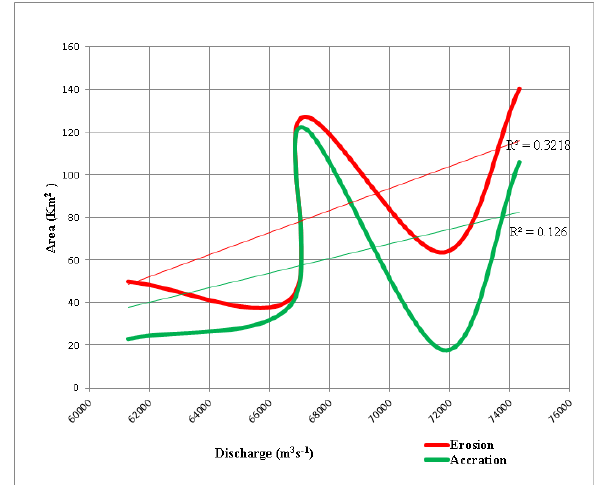
Figure 4. Bars area with time